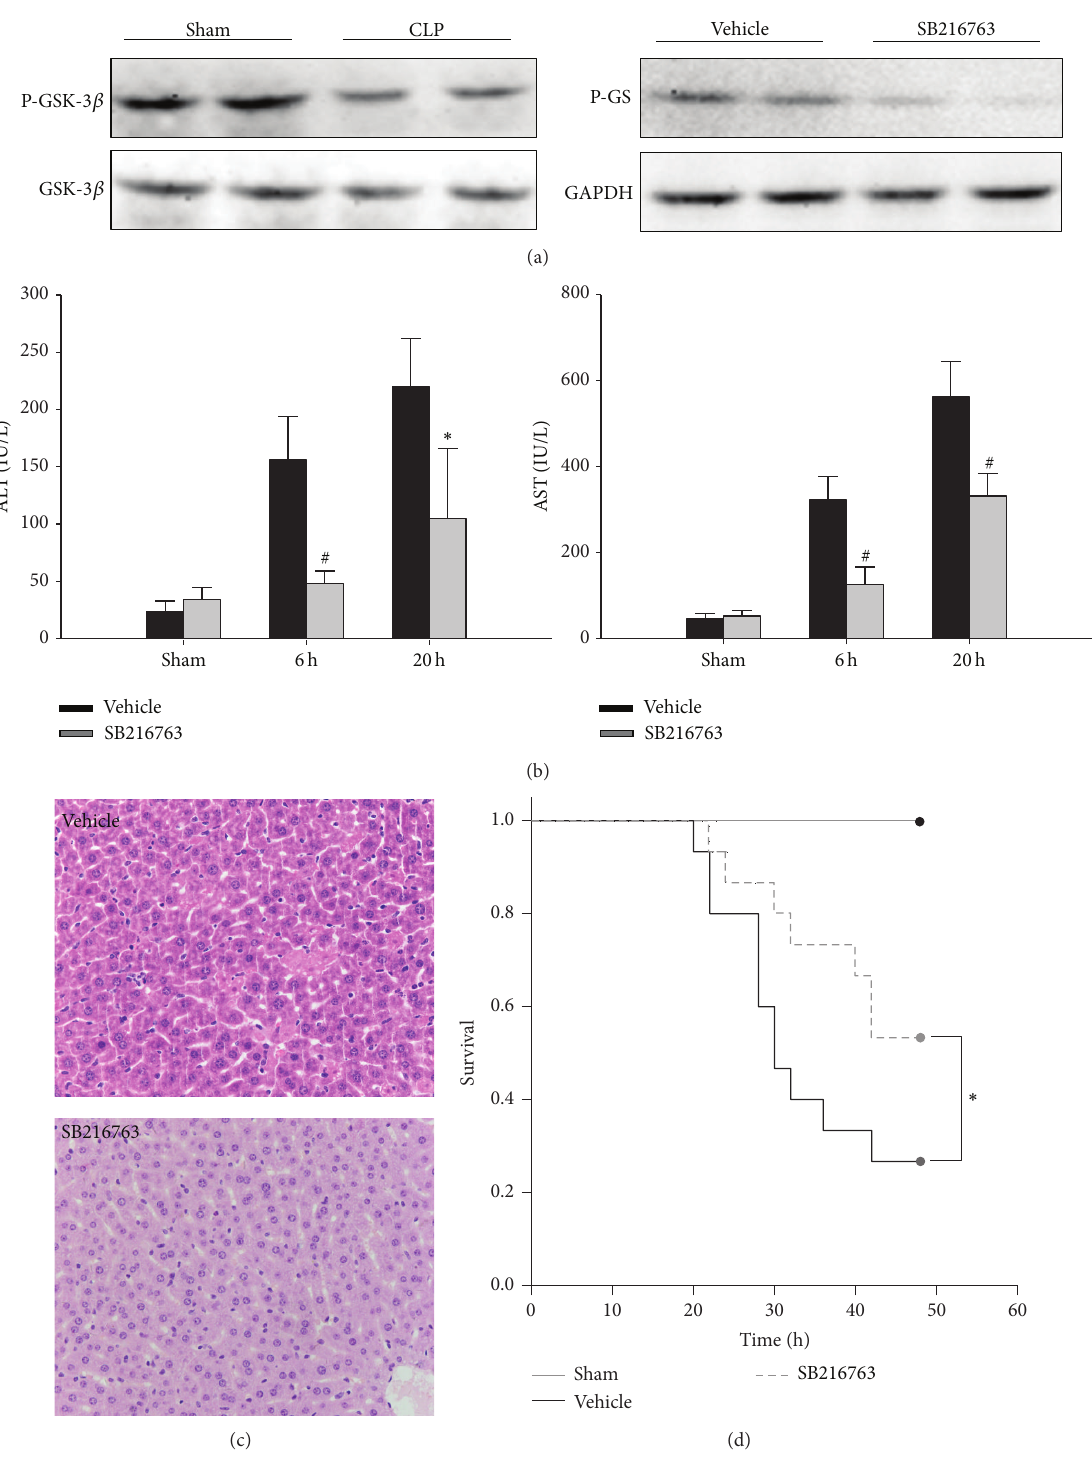
Figure 1: GSK-3 𝛽 inhibition improves survival and protects against CLP-induced liver injury. The septic mice were treated with SB216763 (25 mg/kg, i.p.) or vehicle (DMSO) at 1h, 6h, and 12h after CLP. (a) Liver samples were harvested at 6 h after CLP and were subjected to western blotting analysis of phosphorylated (serine 9) GSK-3 𝛽 and phosphorylated glycogen synthases (GS). (b) ALT and AST levels were analyzed as a measure of hepatocellular injury. Data are shown as mean ± SD. ∗ 𝑃 < 0.05 , # 𝑃 < 0.01 compared with vehicle-treated group. (c) The liver specimens were sampled at 20 h after CLP and stained with hematoxylin and eosin staining (original magnification × 400). Representative images from 6 mice/group were selected. (d) The Kaplan-Meier method was used to determine the difference of survival rate after CLP. 𝑃 value was analyzed by log rank test. ∗ 𝑃 < 0.05 compared with vehicle-treated